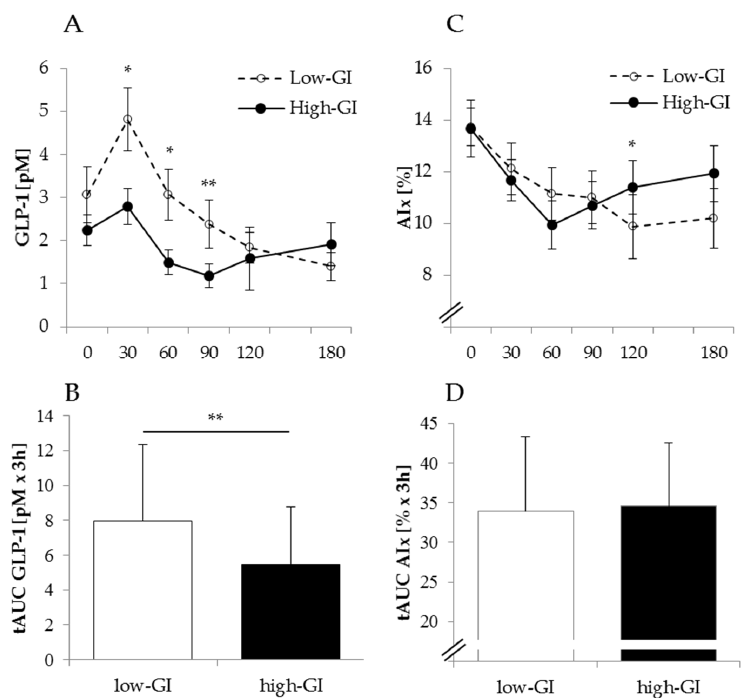
Figure 2. Comparison of postprandial Glucagon ‐ like ‐ peptide 1 (GLP ‐ 1) ( A , B ) levels and augmentation index ( C , D ) after intake of low glycemic index ( ) vs. high glycemic index ( ) SSB at the end of one week of low physical activity. AIx, augmentation index; GLP1, glucagon ‐ like